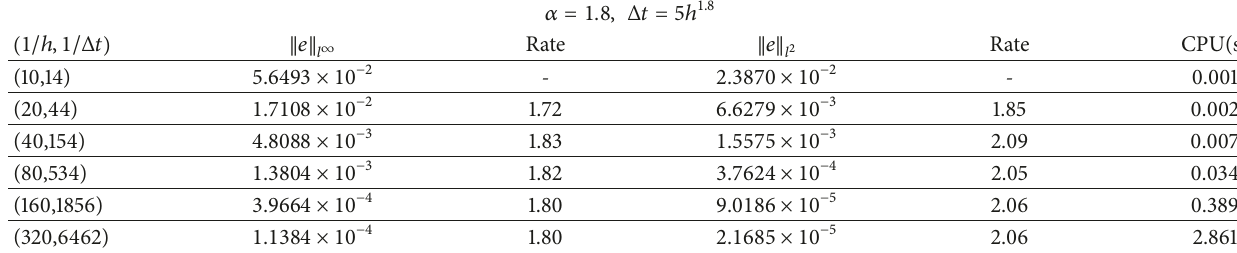
Table 2: Error and convergence rates for Example 1. 𝛼 = 1.8, Δ𝑡 = 5ℎ 1.8